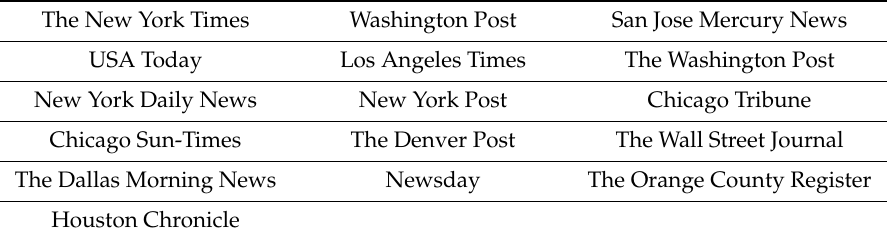
Table 5. The news sources adopted in this